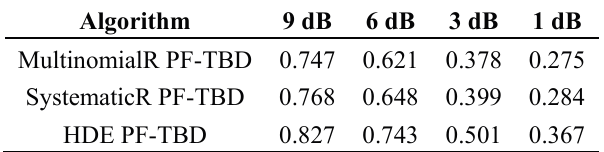
Table 3. The average detection probability for the CT model.